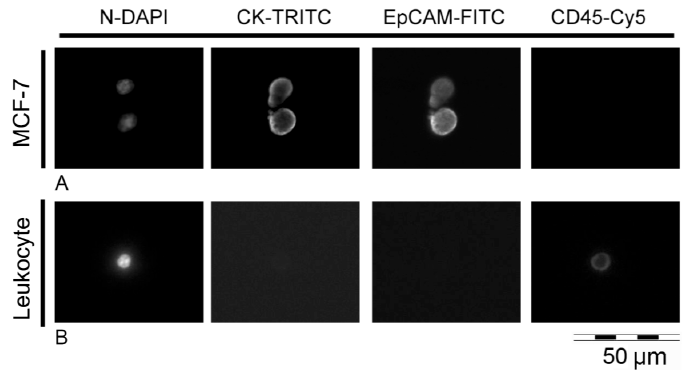
Figure 2. MCF-7 cells and a leukocyte labeled inside the Parsortix™ cassette. ( A ) MCF-7 cells were spiked into healthy donor blood samples and processed within the Parsortix™ system. After capturing within the cassette, tumour cells were permeabilized and stained in situ, and harvested from the system. In fluorescence microscopy MCF-7 cells exhibit signals for nucleic DNA (DAPI), cytokeratins (TRITC) and epithelial cell adhesion molecule (EpCAM-FITC); they are negative for CD45 expression (Cy5); ( B ) A leukocyte captured within the Parsortix™ system and stained in situ with the same DAPI/antibodies mastermix, shows positive staining of the nucleus (DAPI) and of CD45 (Cy5). There is no expression of cytokeratins (TRITC) and EpCAM (FITC). Magnification: 40×.